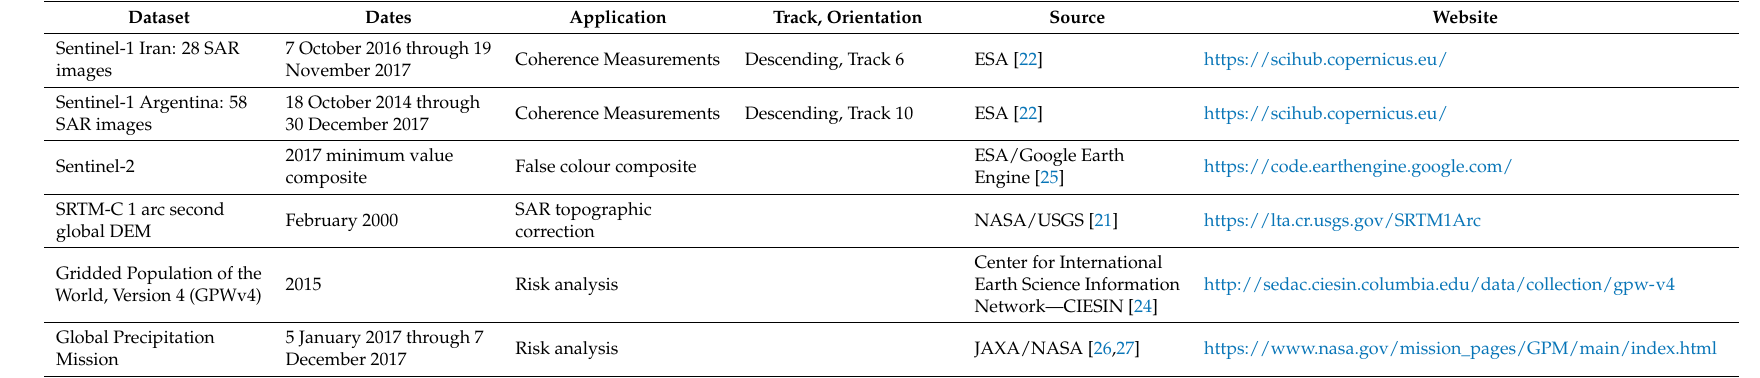
Table 1. Summary of data used in case studies, date ranges, application, and